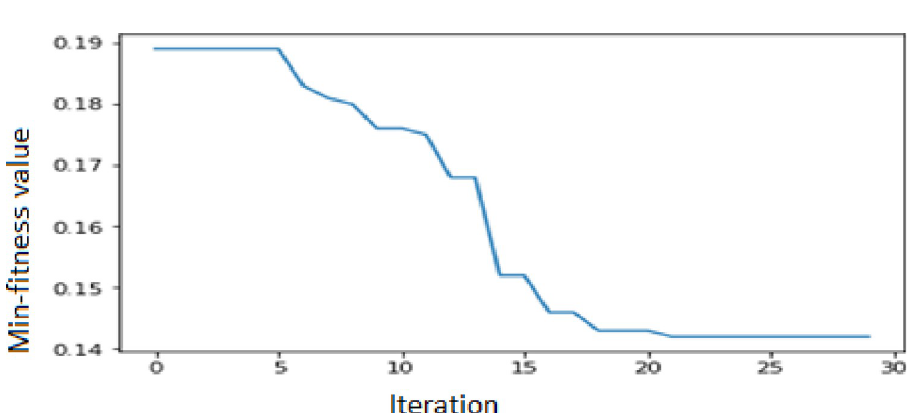
Fig 5. APSO–CNN algorithm’s minimal fitness values modified over